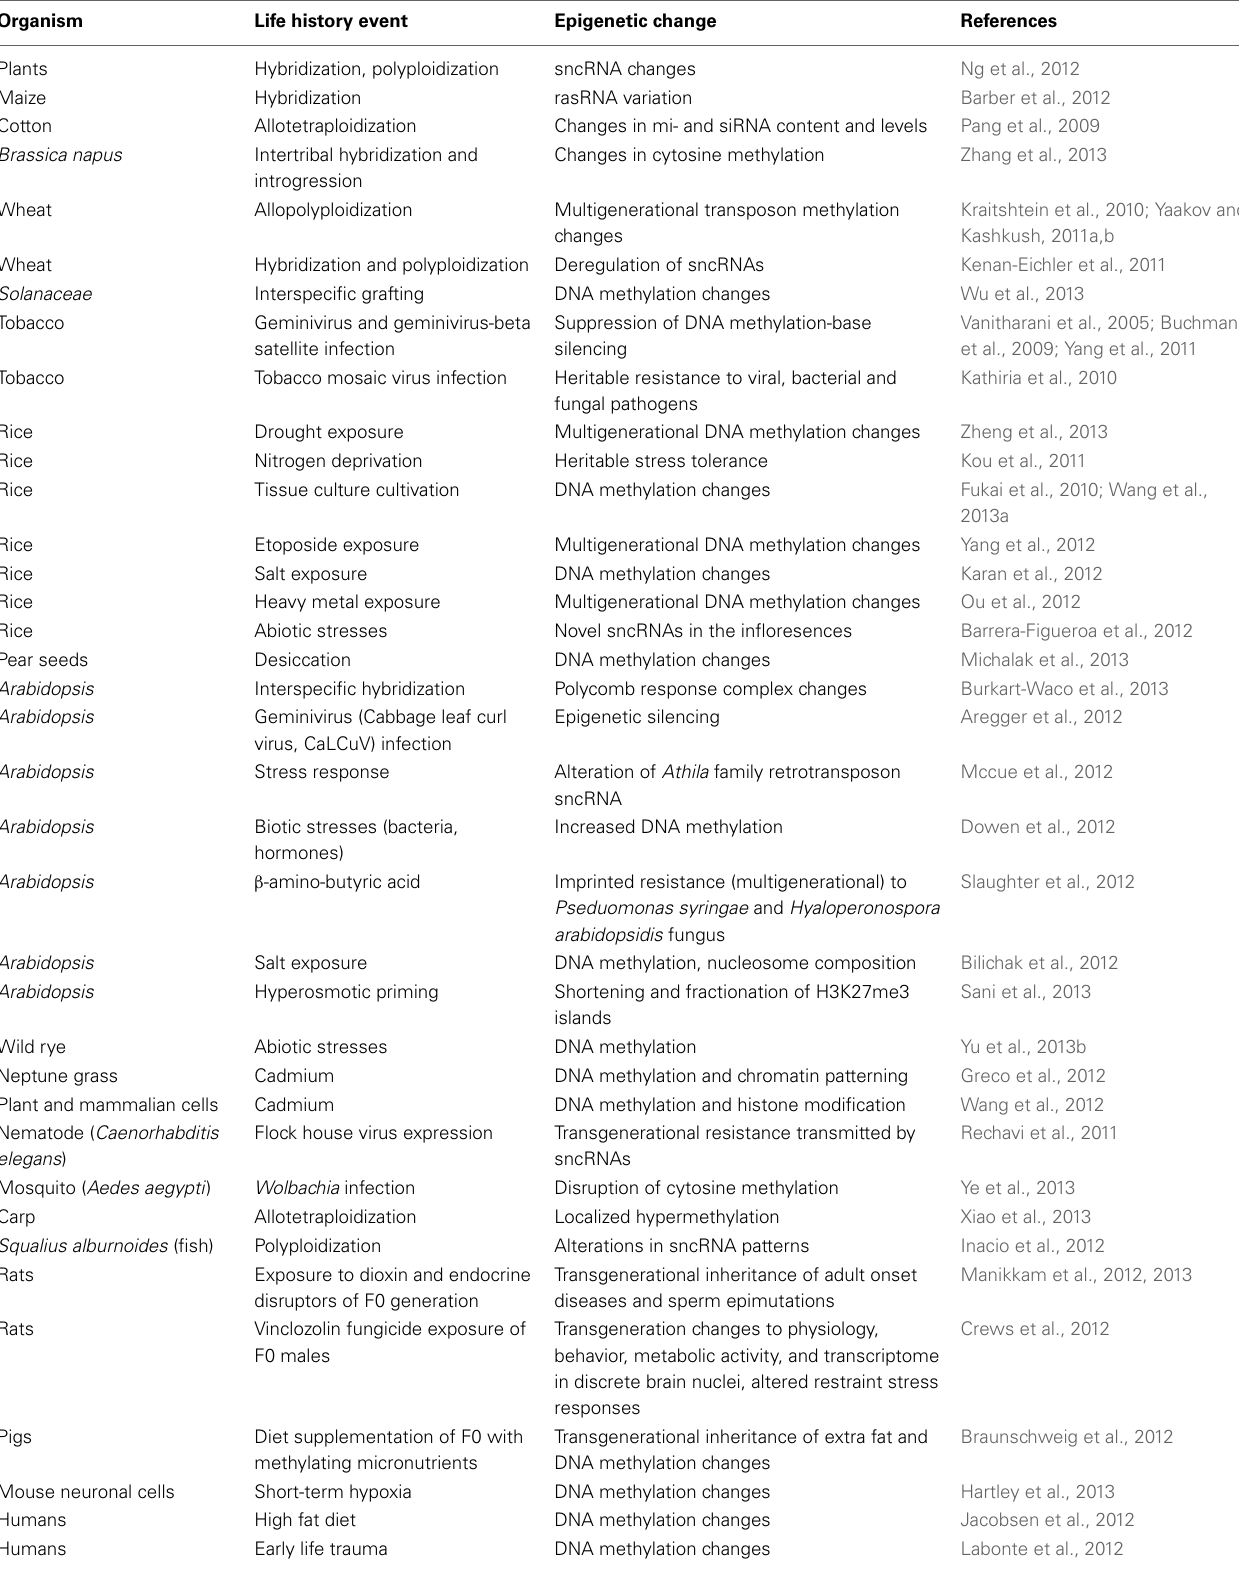
Table 3 | Life history events that induce epigenetic changes (see also http://shapiro.bsd.uchicago.edu/TableII.10.shtml for earlier